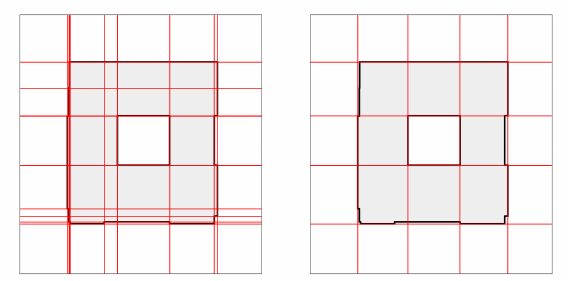
Figure 4: Cell decomposition without (left) and with removal of lines extrapolated from short footprint edges